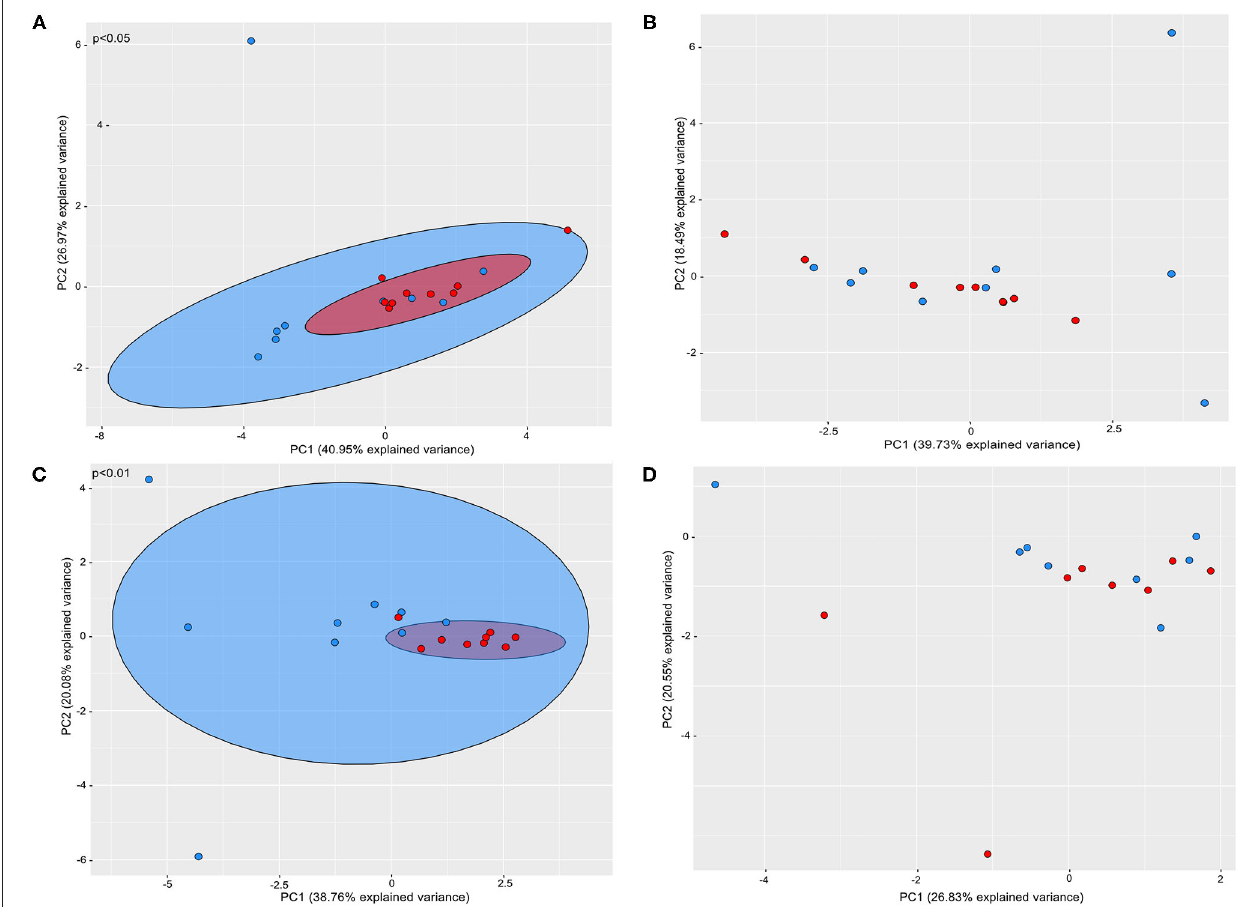
FIGURE 2 | Principal coordinate analysis based on weighted UniFrac distance metric. Graphics represents beta diversity analysis between samples of P and H groups: (A) supragingival sites; (B) subgingival non-affected sites; (C) subgingival affected sites of P and subgingival sites of H (D) feces of H and P. Red dots correspond to samples of Periodontitis patients and blue dots to samples of health subjects. A significance level of 5% was applied by using PERMANOVA